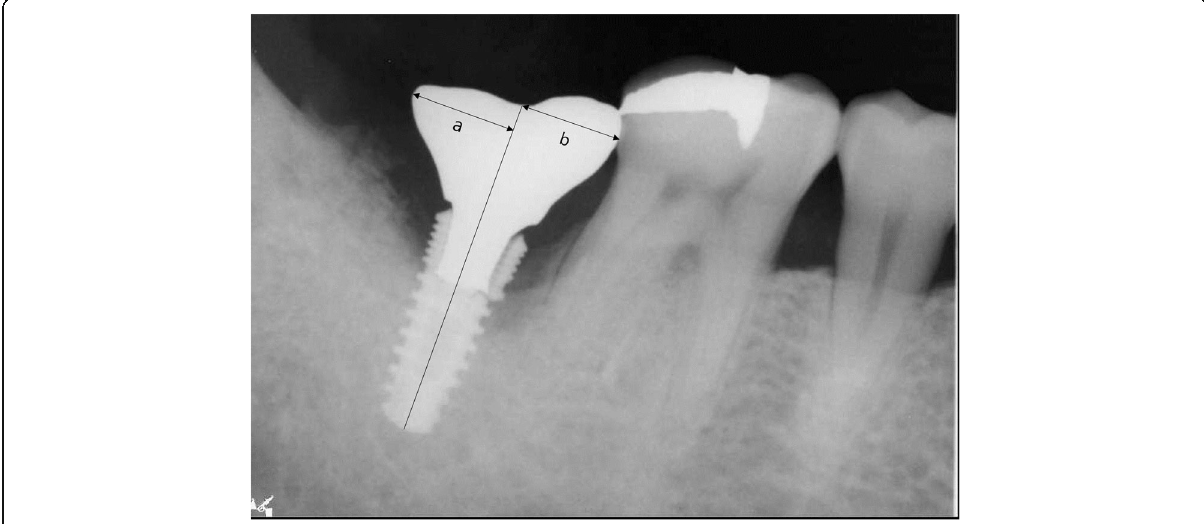
Fig. 1 The method of determining a single implant cantilever (mesiodistal cantilever). If the difference between the length of “ b ” (distance from the midline to the longest part of the mesial) and the length of “ a ” (distance from the midline to the longest part of the distal) is greater than 2 mm, it is considered a mesiodistal cantilever. In this figure, fixture fracture occurred at the bottom of the prosthesis fixation screw and marginal bone loss were observed up to this